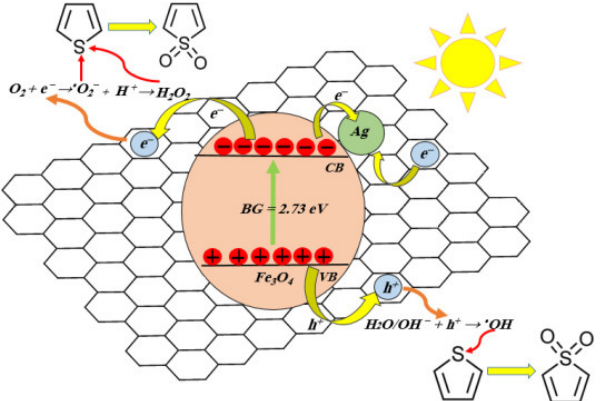
Figure 4. Mechanism for the separation of photogenerated electron–hole pairs in the Ag/Fe 3 O 4 /graphene photocatalyst. Reproduced from ref. [68] with permission from Elsevier. Copyright 2021 Elsevier.